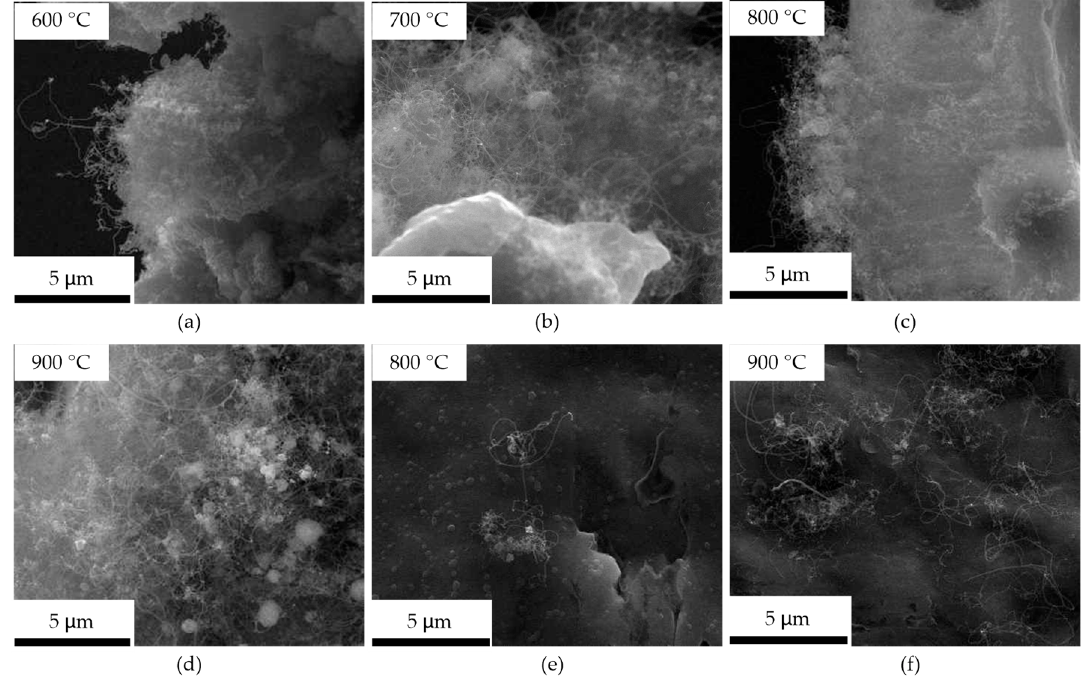
Figure 3. The SEM micrographs of the CNTs obtained at 600, 700, 800, and 900 °C on the aluminum foil. ( a – d ) is the CNTs grown on the edge at 600, 700, 800, and 900 °C; ( e , f ) is the CNTs grown on the surface at 800 and 900 °C.